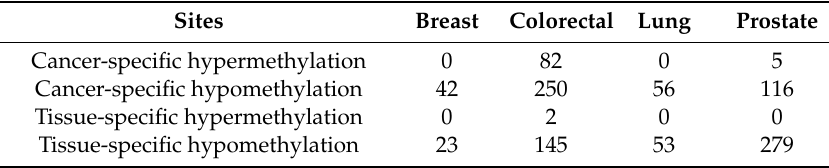
Table 3. Tally of di ff erentially methylated CpG sites predicted by MethylMine.